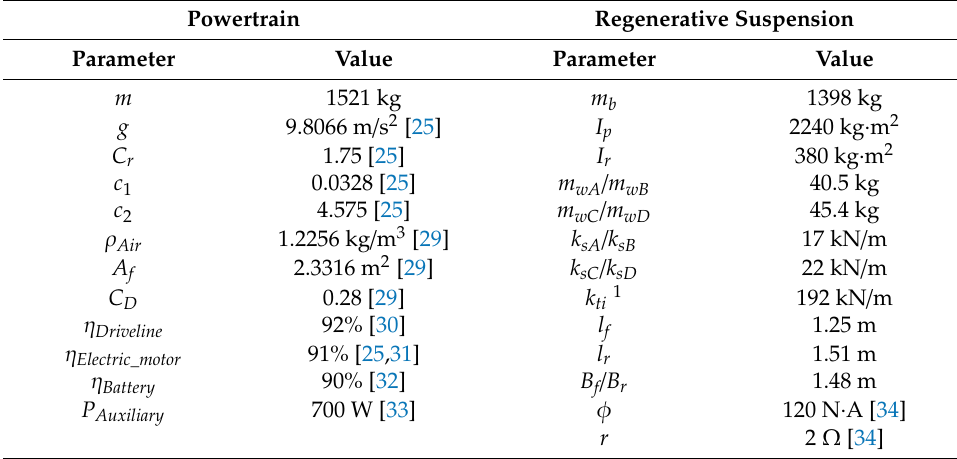
Table 2. Vehicle model parameters. 1 i = A , B , C, D .